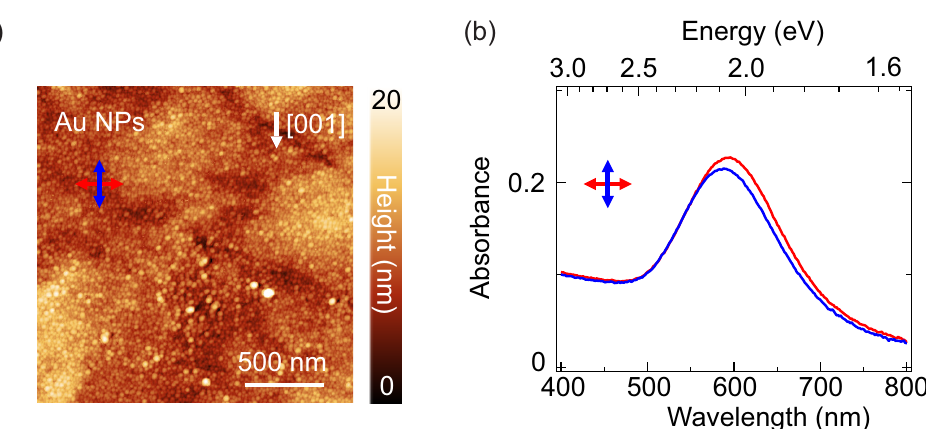
Figure A1. ( a ) AFM image of the plasmonic array of Au NPs. The scanned area is 2 × 2 µ m 2 . The white arrow indicates the elongation direction of the Au NP chains. The red and blue arrows correspond to the light linear polarization direction, respectively, parallel and perpendicular to the Au NP chains. ( b ) In the graph, the corresponding absorbance spectra are